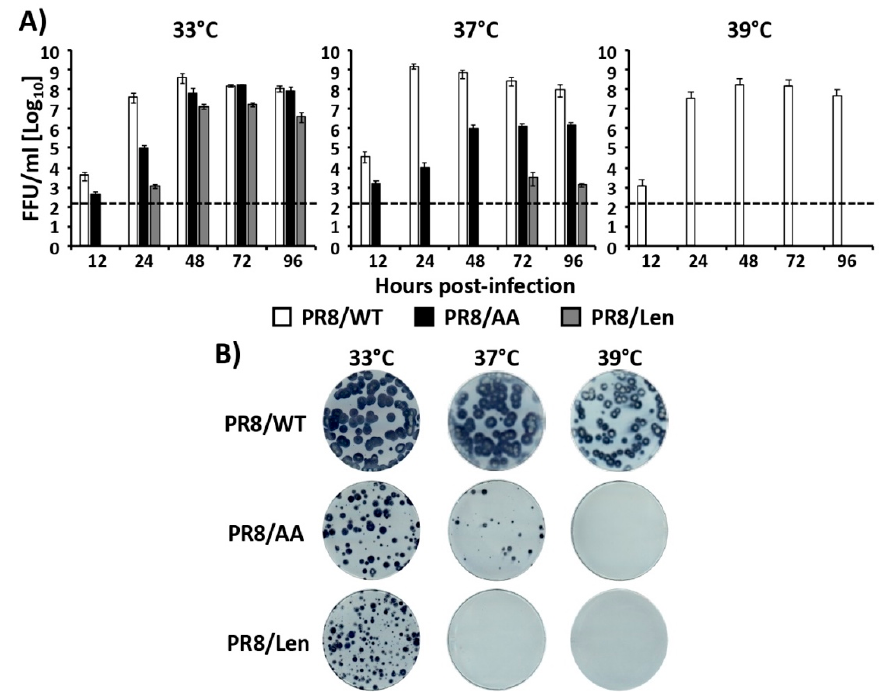
Figure 3. In vitro characterization of PR8 / AA and PR8 / Len viruses. ( A ) Multicycle growth kinetics: MDCK cells (12-well plate format, 4 × 10 5 cells / well, triplicates) were infected at low MOI (0.001) with PR8 / WT (white bars), PR8 / AA (black bars) and PR8 / Len (grey bars) viruses and placed at 33 ◦ C, 37 ◦ C, or 39 ◦ C. Tissue culture supernatants were recovered at the indicated times post-infection (p.i.) and viral titers were determined by immunofocus assay (FFU / mL) using an anti-NP mAb (HB-65). Data represent the means and SDs of the results determined from triplicate wells. Dotted black lines indicate the limit of detection (200 FFU / mL). ( B ) Plaque assays: MDCK cells (6-well plate format, 1 × 10 6 cells / well) were infected with PR8 / WT, PR8 / AA or PR8 / Len viruses and incubated at 33 ◦ C, 37 ◦ C, or 39 ◦ C for 3 days. Plaque phenotype was assessed by immunostaining with the HB-65 anti-NP mAb.